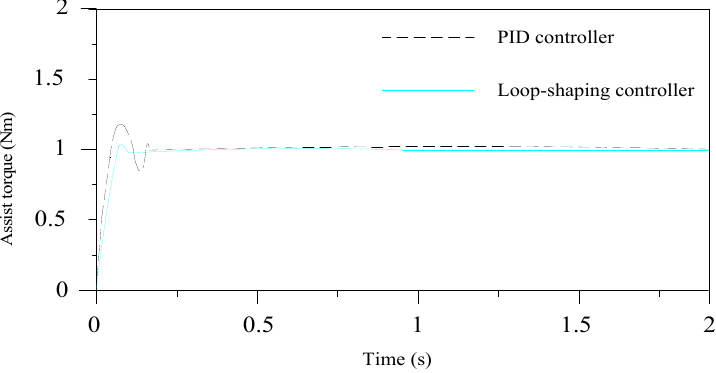
an objective comparison of the different controllers in Table 11.